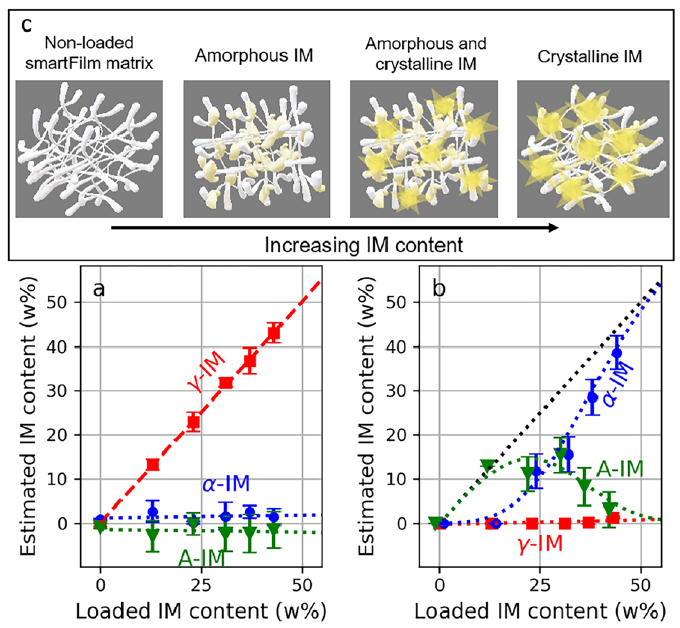
Figure 3. Estimated content of A- (green triangles), α - (blue circles), and γ -IM (red squares) for the physical mixture samples ( a ) and the smartFilm samples ( b ). The red dashed line corresponds to the linear fit. All the dotted lines are provided as a guide-to-the-eye and represent no particular model. Additionally, for visualization purposes, the green and blue value markers in ( b ) were artificially shifted for +1% and -1% in the horizontal direction, respectively. ( c ) Schematic presentation of amorphous and crystalline IM loaded in the